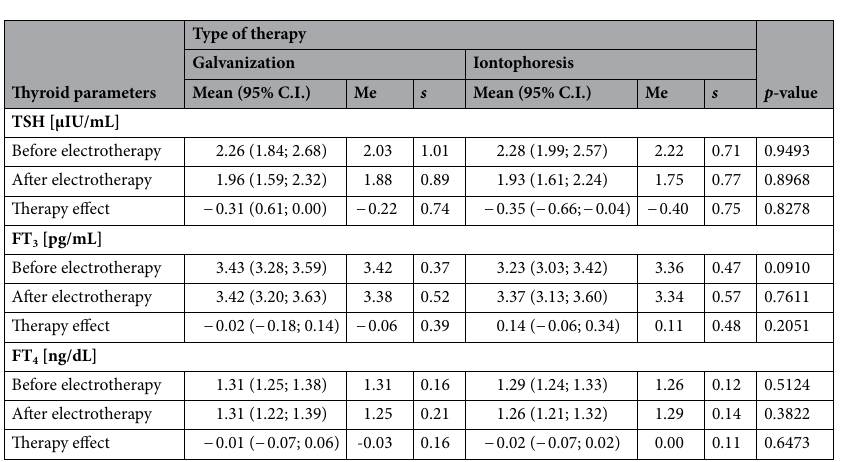
Table 2. Changes in TSH, FT 3 and FT 4 levels in the study groups from T1 to T2. p -test probability value calculated using the independent samples t-test.